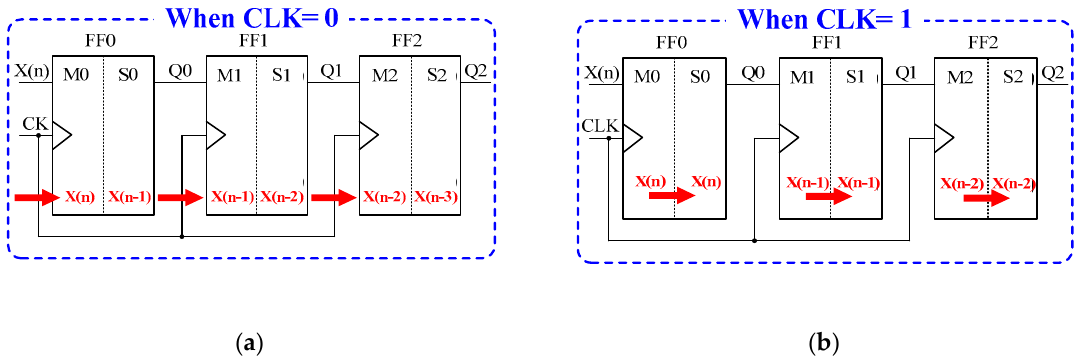
Figure 1. Data transmission of a conventional shift register. ( a ) When CLK = 0. ( b )When CLK = 1.